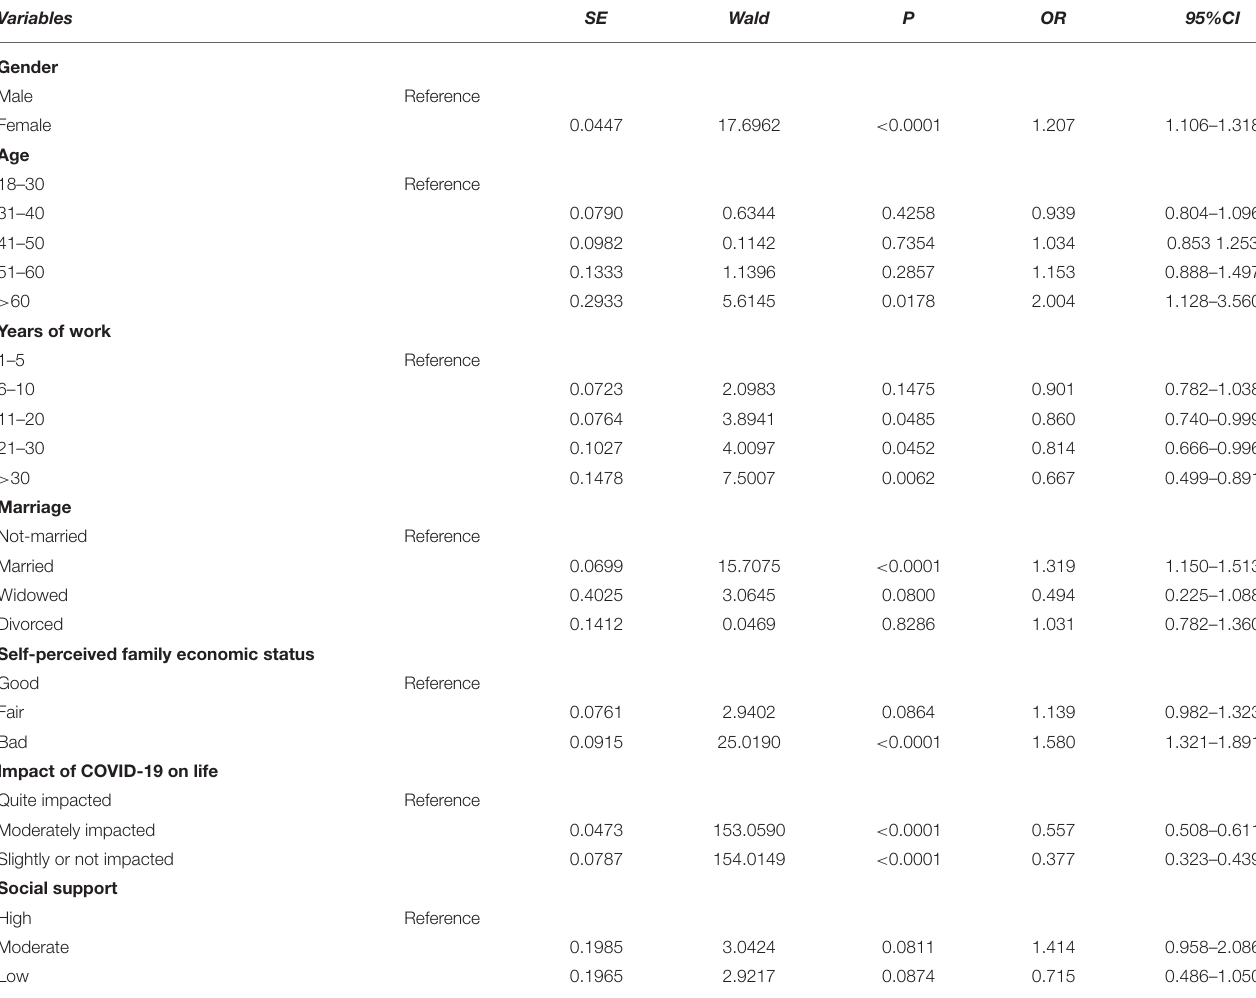
TABLE 2 | Multivariate logistic regression analysis of factors associated with university anxiety among university